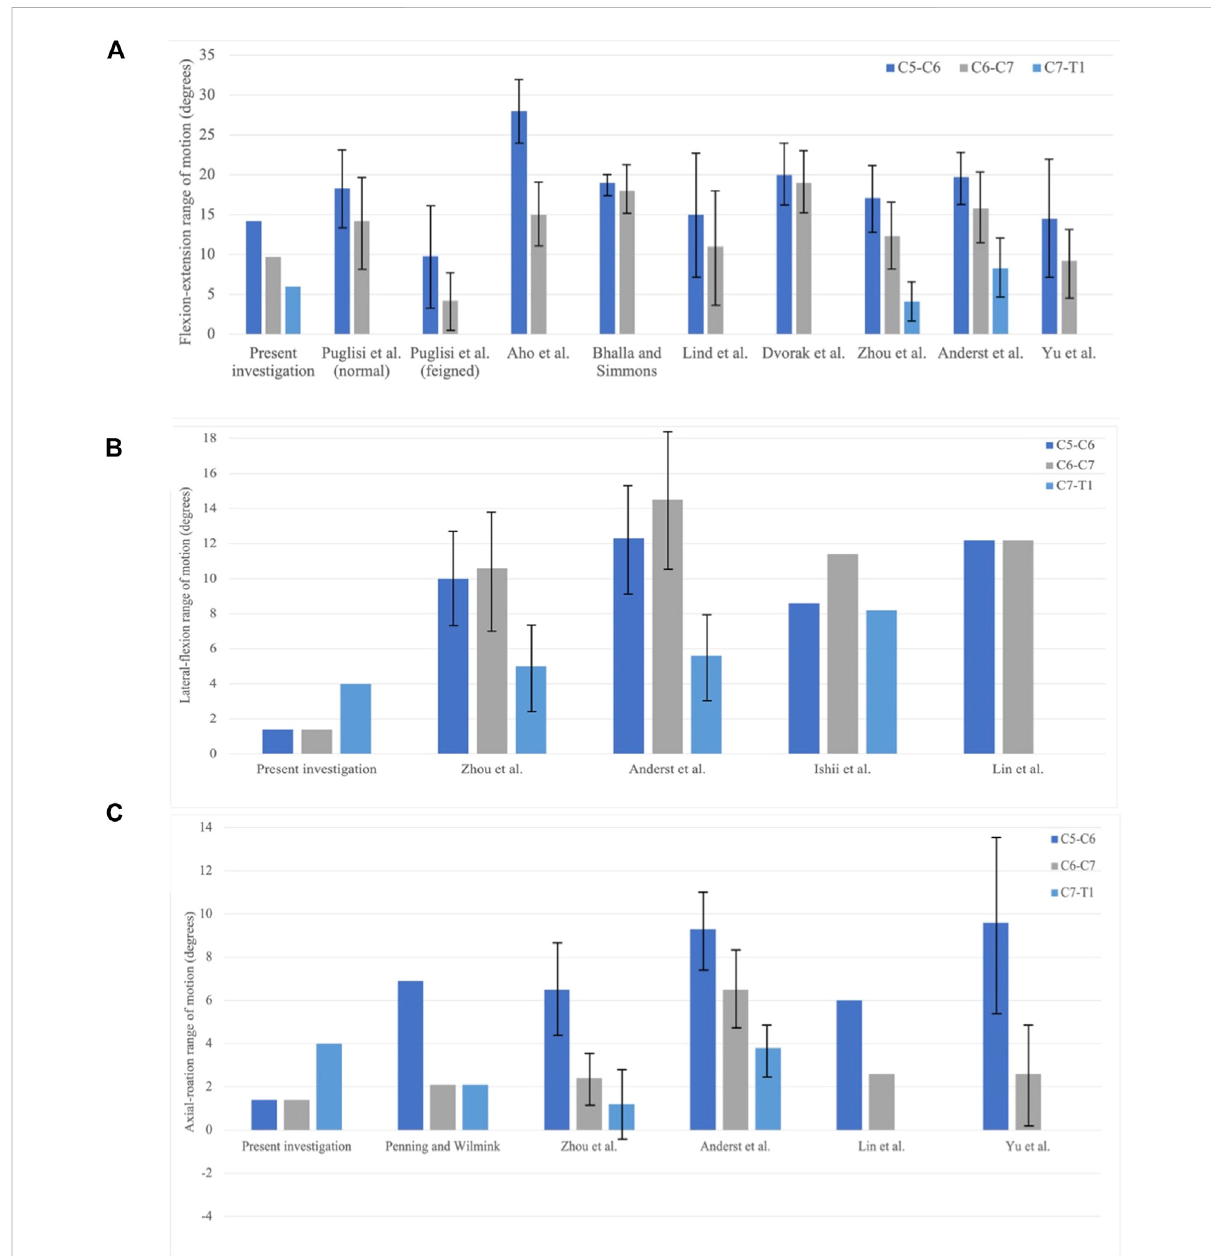
FIGURE 7 Comparison of the range of motion (ROM) in between the present investigation and experiment results. C5 – C6, C6 – C7, and C7 – T1 joints are collected. (A) Flexion – extension; (B) lateral – fl exion; and (C) axial rotation (Bogduk and Mercer, 2000; Puglisi et al.,